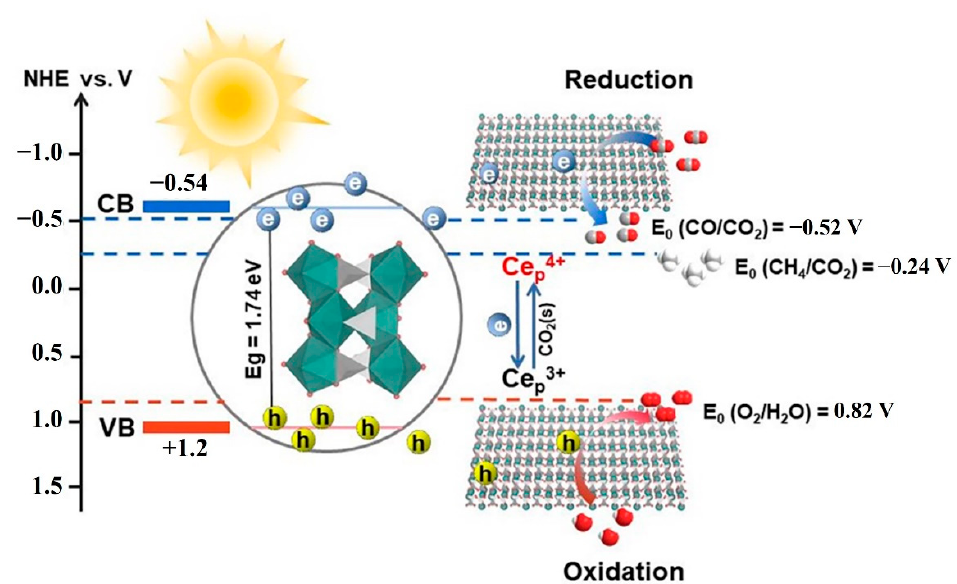
Figure 9. Schematic illustration of the catalytic pathways for the photocatalytic CO 2 reduction with H 2 O vapor.